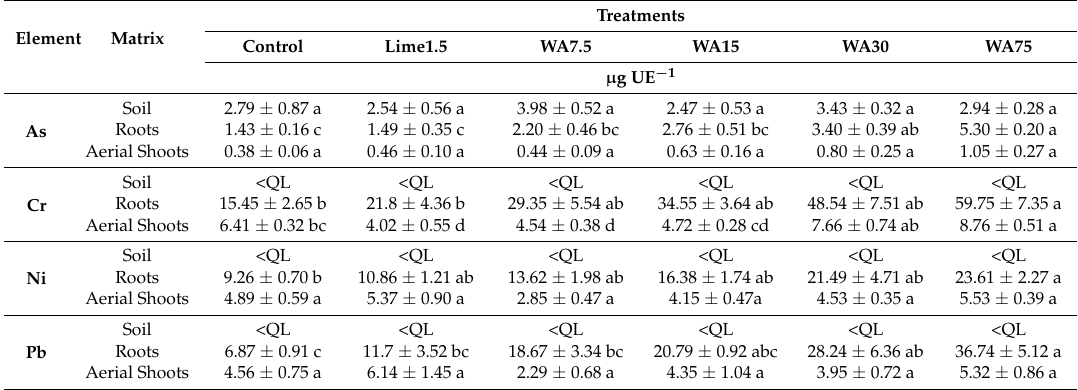
Table 4. Heavy metal(oid)s content in the soil-plant